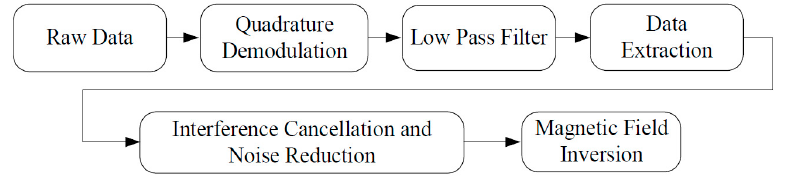
Figure 3. NMR data processing flow chart. The demodulation frequency is 24.65 MHz. The pass band of the digital low pass filter is 0–600 kHz, and the cutoff frequency is 1 MHz.